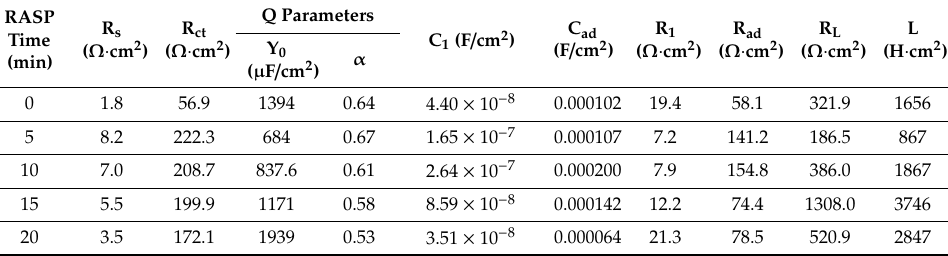
Table 5. Equivalent-circuit element values for EIS data corresponding to the SA106B low-carbon steel